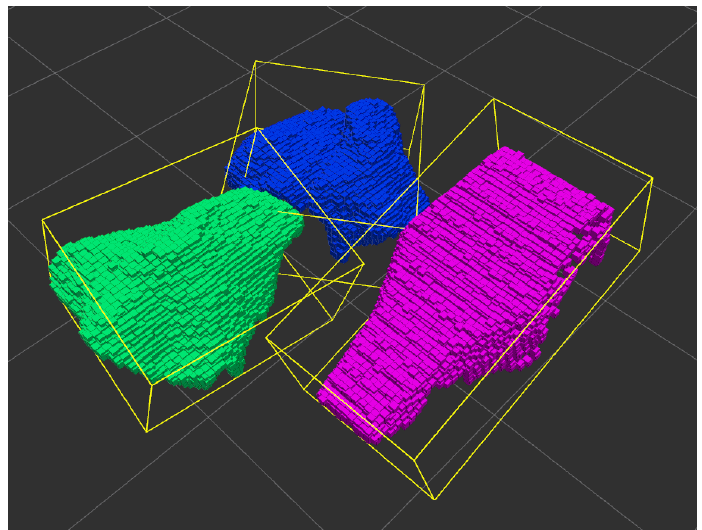
Figure 8. Segmented cloud input and bounding box representation of each rock